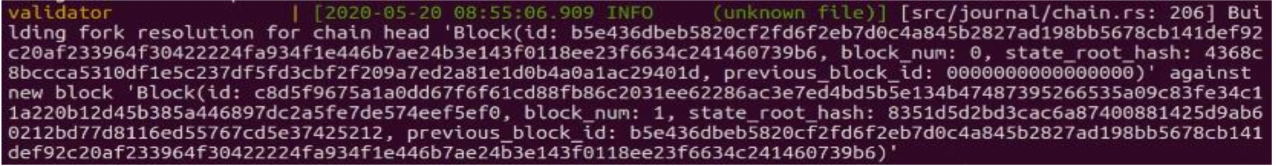
Figure 7. Sawtooth validator initiate system validation (register()).